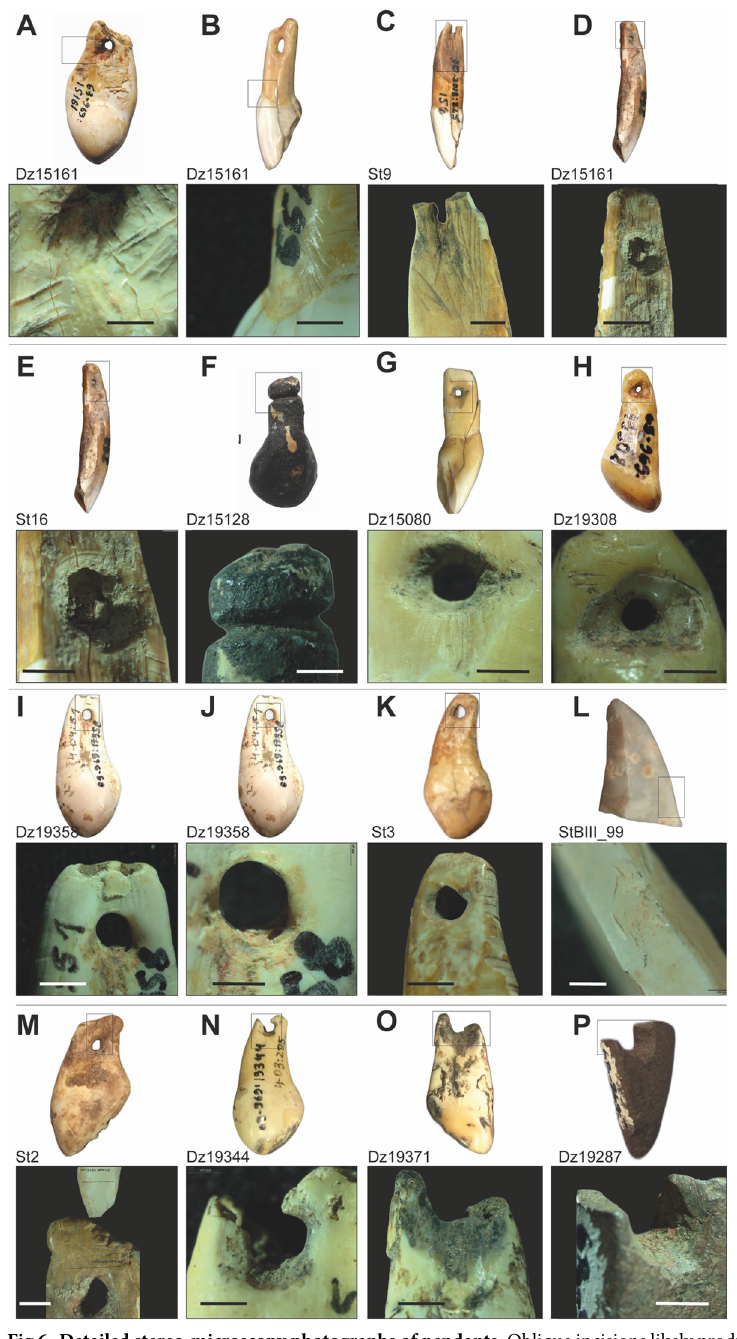
Fig 6. Detailed stereo-microscopy photographs of pendants. Oblique incisions likely produced to remove the teeth from the alveolar cavity (A, B); Longitudinal scraping on the surface of the roots before perforation (C, D); circular marks on the hole resulting from a rotating action to perforate the teeth (E); transversal segmentation of the root by sawing and peripheral gouging by scraping (F); Longitudinal incisions marks resulting from the perforation by scraping (G); circular perforations modified by use-wear resulting in a polish lobe of the hole (G–K); flint burin from layer B/III of Satsurblia bearing ochre remains and compatibility between its distal (active) part and the scraped and perforated surface of a teeth from the same layer (L, M); ochre stains on the holes (H, J, P); red deer vestigial canine from Satsurblia decorated with transversal notches on its root (K); functional breakages of the perforations (N–P). All scales = 1 mm. Magnifications 7-16x. Photos by J.-M.